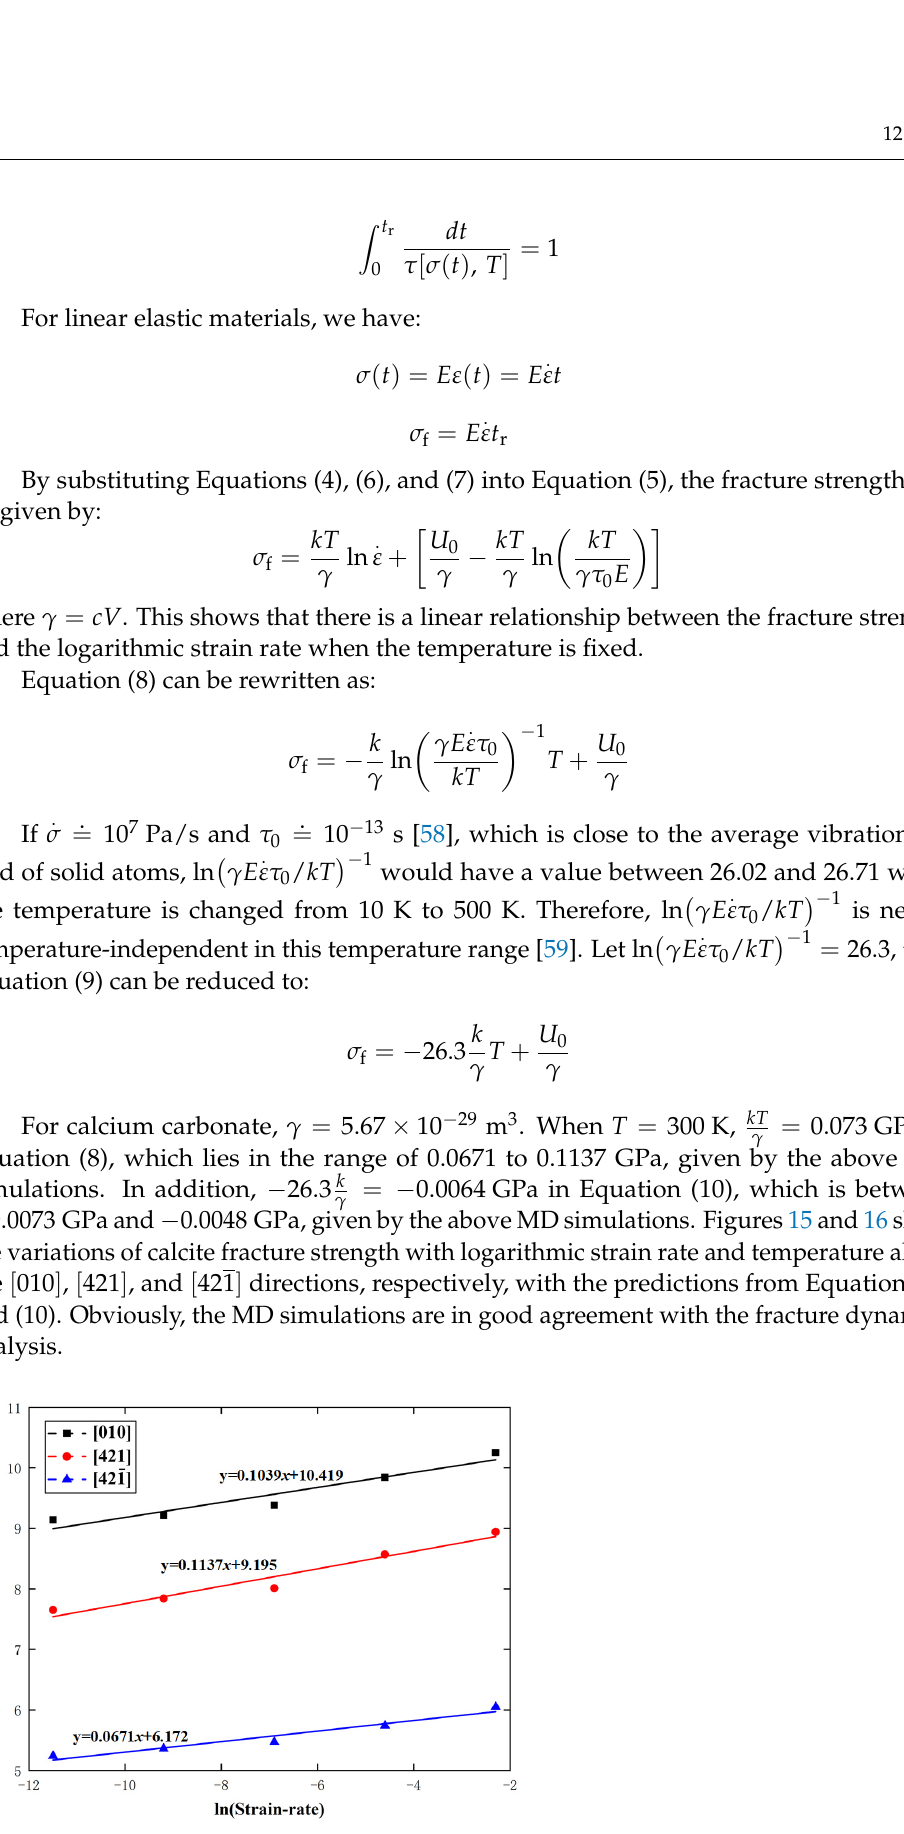
Figure 16. Variations of fracture strength with temperature along the [010] , [421] , and [421] di- rections. 4. Conclusions In this paper, the mechanical properties of single-crystal calcite, as well as their tem- perature and strain-rate effects, were studied by MD simulations. Single-crystal calcite’s tensile failure behavior exhibits typical quasi-brittleness characteristics. The elastic mod- uli obtained by the simulations are very close to the experimental value, which confirms the reliability of MD simulations. The fracture strength, fracture strain, and elastic modu- lus are all highly anisotropic. The fracture strength and elastic modulus along the [010] direction is much higher than those along the [421] and [421] directions. High anisot- ropy is caused by different failure and deformation mechanisms in different directions, including dislocation initiation and development, phase transition, and void formation. It is found that the fracture strength, fracture strain, and elastic modulus are all very sensi- tive to temperature, but only elastic modulus is not sensitive to strain rate. The variations of fracture strength with temperature and logarithmic strain rate are in good agreement with the predictions of fracture dynamics. Author Contributions: Conceptualization, C.L. and X.Y.; methodology, C.L. and J.L.; software, C.L. and J.L.; Validation, X.Y.; formal analysis, X.Y.; investigation, C.L.; resources, C.L. and J.L.; data curation, C.L.; writing—original draft preparation, C.L.; writing—review and editing, X.Y.; funding acquisition, X.Y. All authors have read and agreed to the published version of the manuscript.